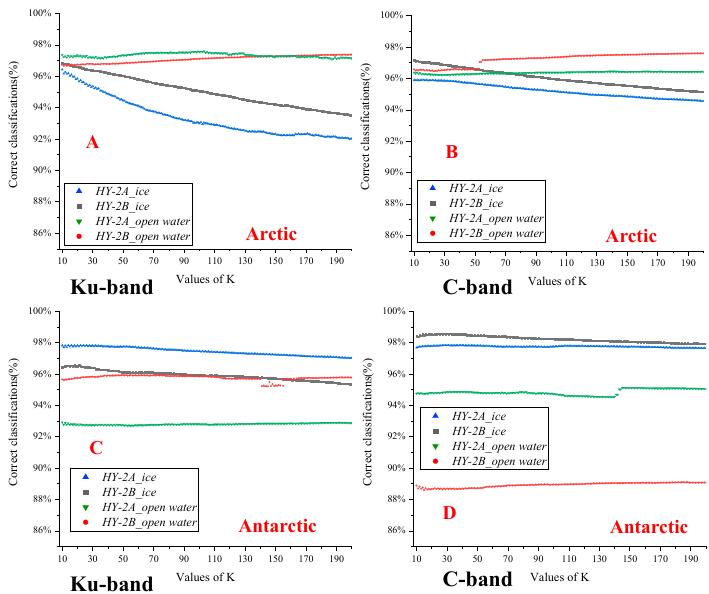
Figure 17. Classification accuracy rates of the different K values: Figure 17A,B used the data in the Arctic regions; Figure 17C,D used the data in the Antarctic regions; The data of Band Ku were used in Figure 17A,C; The data of Band C were used in Figure 17B,D.